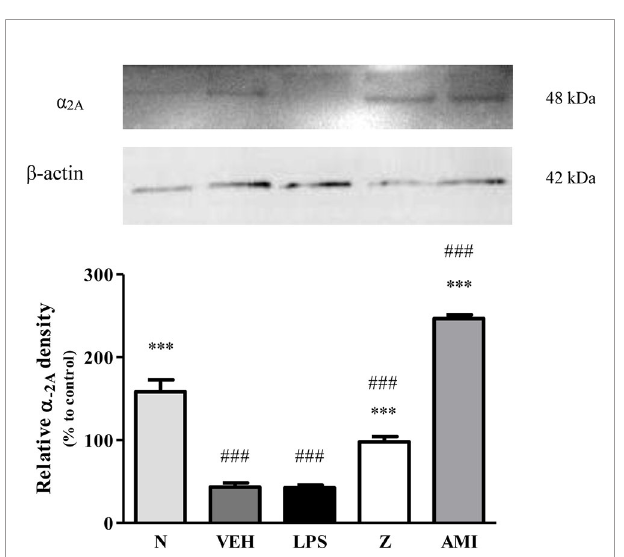
FIGURE 12 | Representative western blots of a 2A -adrenergic receptor from LPS- induced SH-SY5Y cells samples of normal, vehicle, LPS only, zerumbone, amitriptyline-treated groups. Data presented as mean ± SEM (n = 4), which were normalized to b -actin. *** p < 0.001 as compared to LPS only group and ### p < 0.001 as compared to normal group. N (Normal); VEH (Vehicle, PBS); Z (Zerumbone, 8 m g/ml); AMI (Amitriptyline, 16 m g/ml).